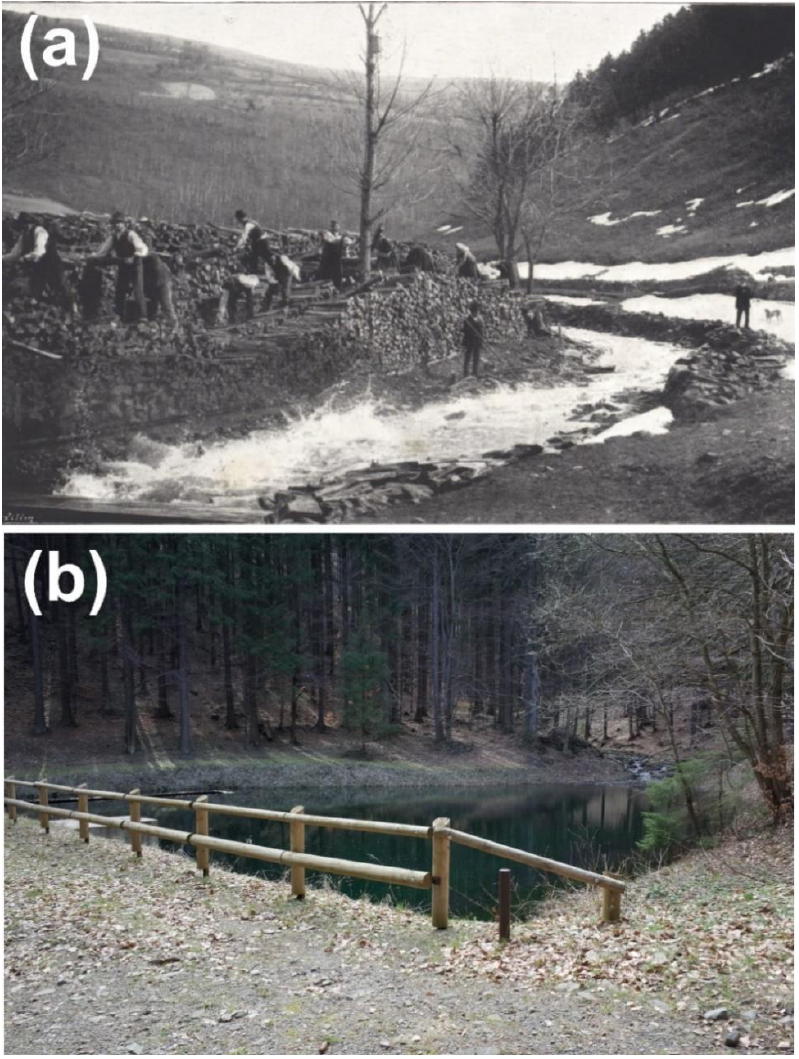
Figure 4. Features connected with historical timber floating: ( a ) timber floating in Dolní Bečva in the 1890s, noting the lack of riparian vegetation on the stream banks (source: [43]), ( b ) splash dam Kyčerov, used for timber floating until the 1920s and completely reconstructed in the 2010s (reservoir capacity is 1500 m 3 ).